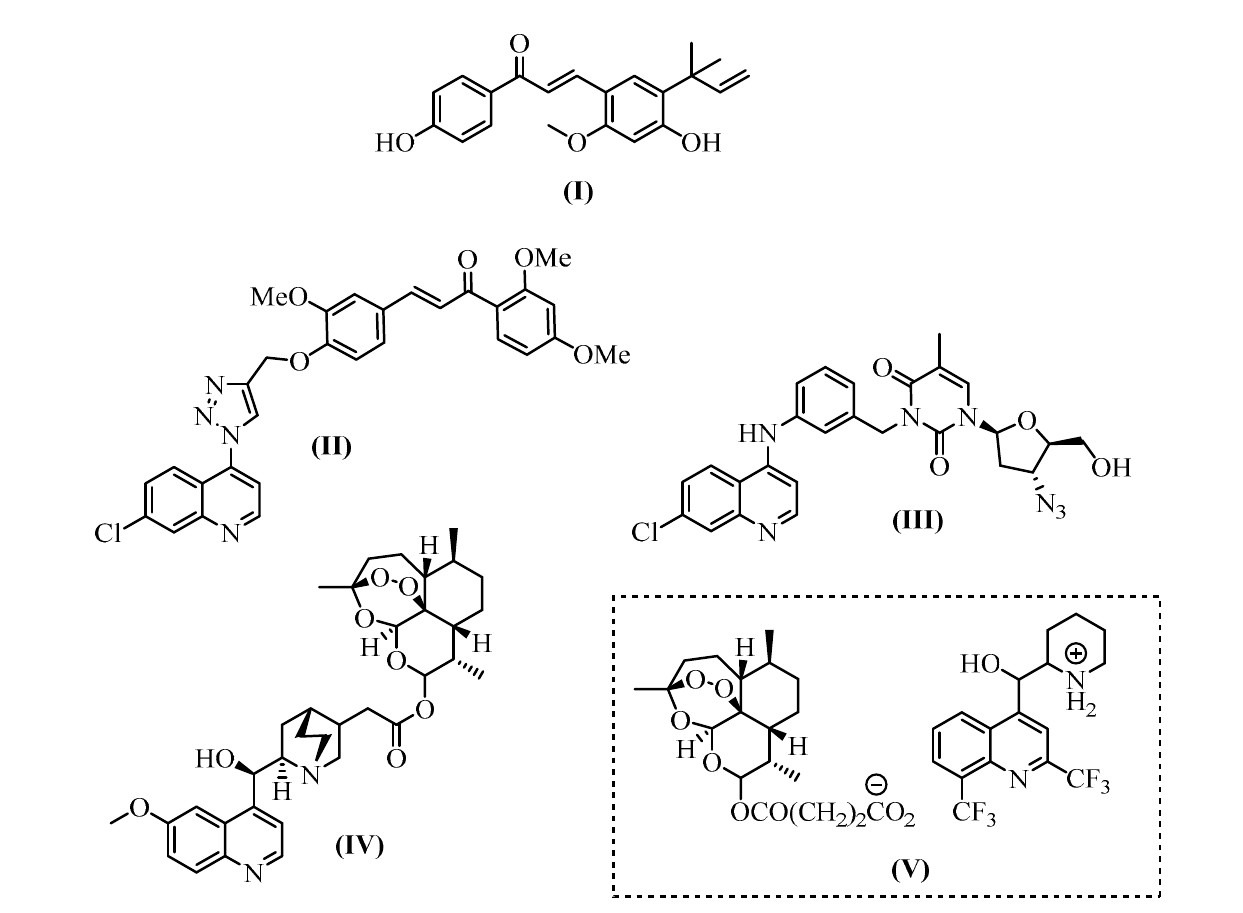
Figure 1. Structures of licochalcone ( I ) and molecular hybrids II–V.